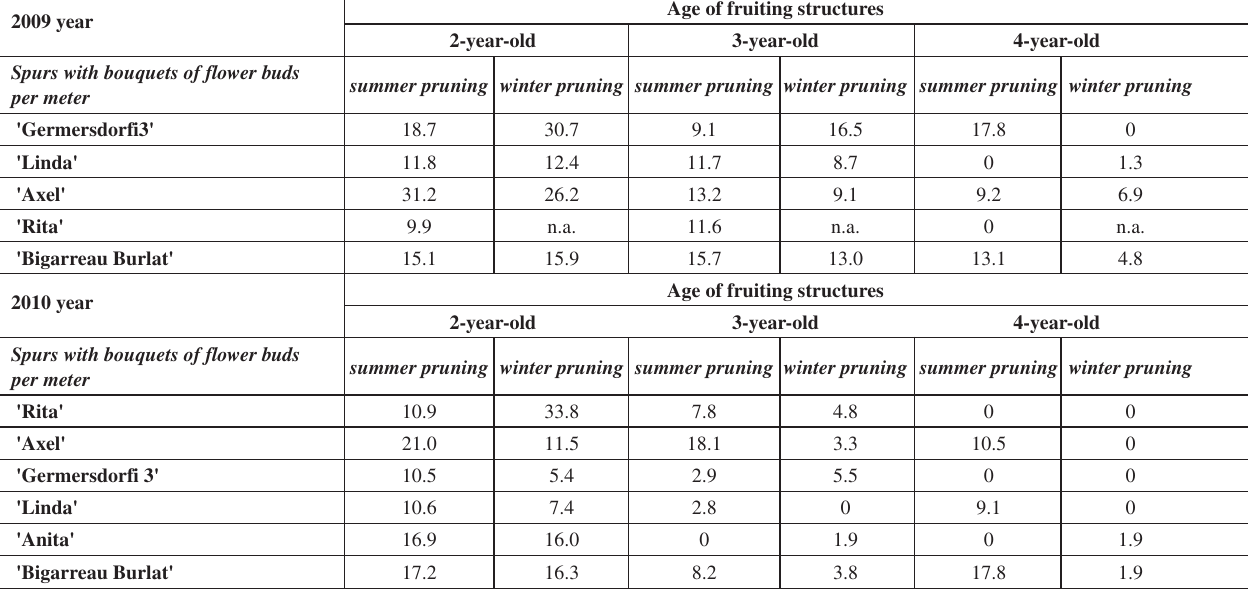
Table 1. Load of flower buds on the woods of different age in sweet cherry varieties (Debrecen-Pallag